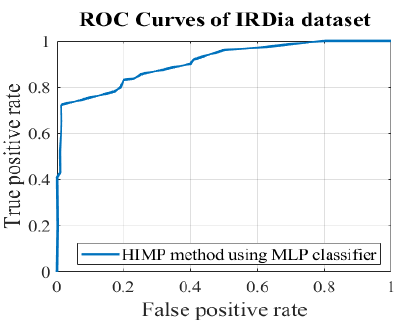
Figure 6. ROC curve of the best performance of the HIMP method